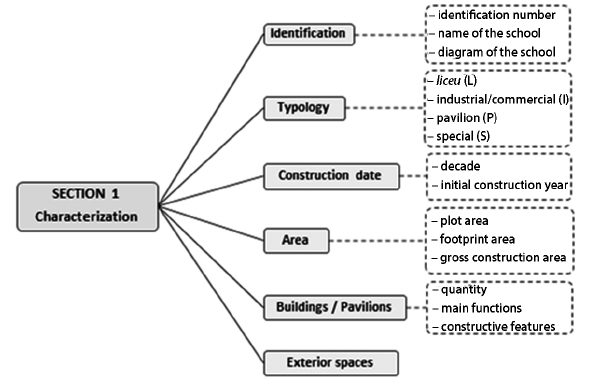
Fig. 5. Organogram of the parameters included in the characterization of the school buildings section